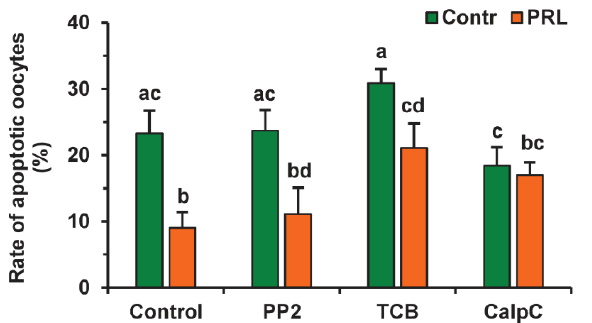
Figure 8. Effects of PRL (50 ng/mL) on oocyte apoptosis during the 24 h aging of bovine CEOs in the presence and in the absence of PP2 (20 µ M), triciribine (TCB, 50 µ M), and calphostin C (CalpC; 1 µ M). Data represent means ± SEM of 4 replicates using 52–80 oocytes per treatment. Means marked with different letters differ significantly (at least p < 0.05).